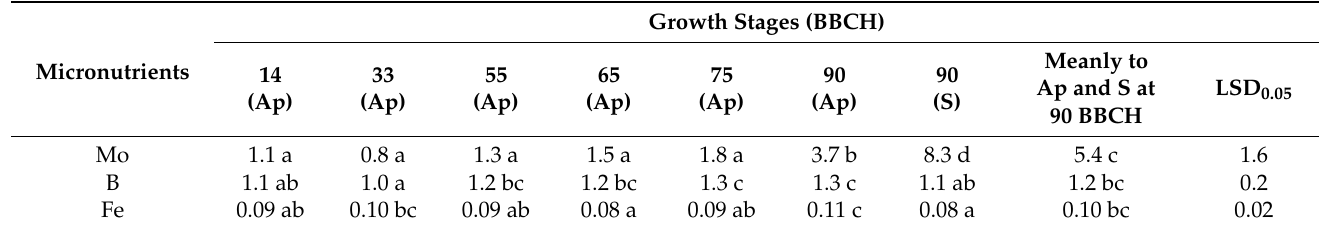
Table 9. Translocation factors of Mo, B, and Fe to aerial parts (Ap) and seeds (S) of a pea.